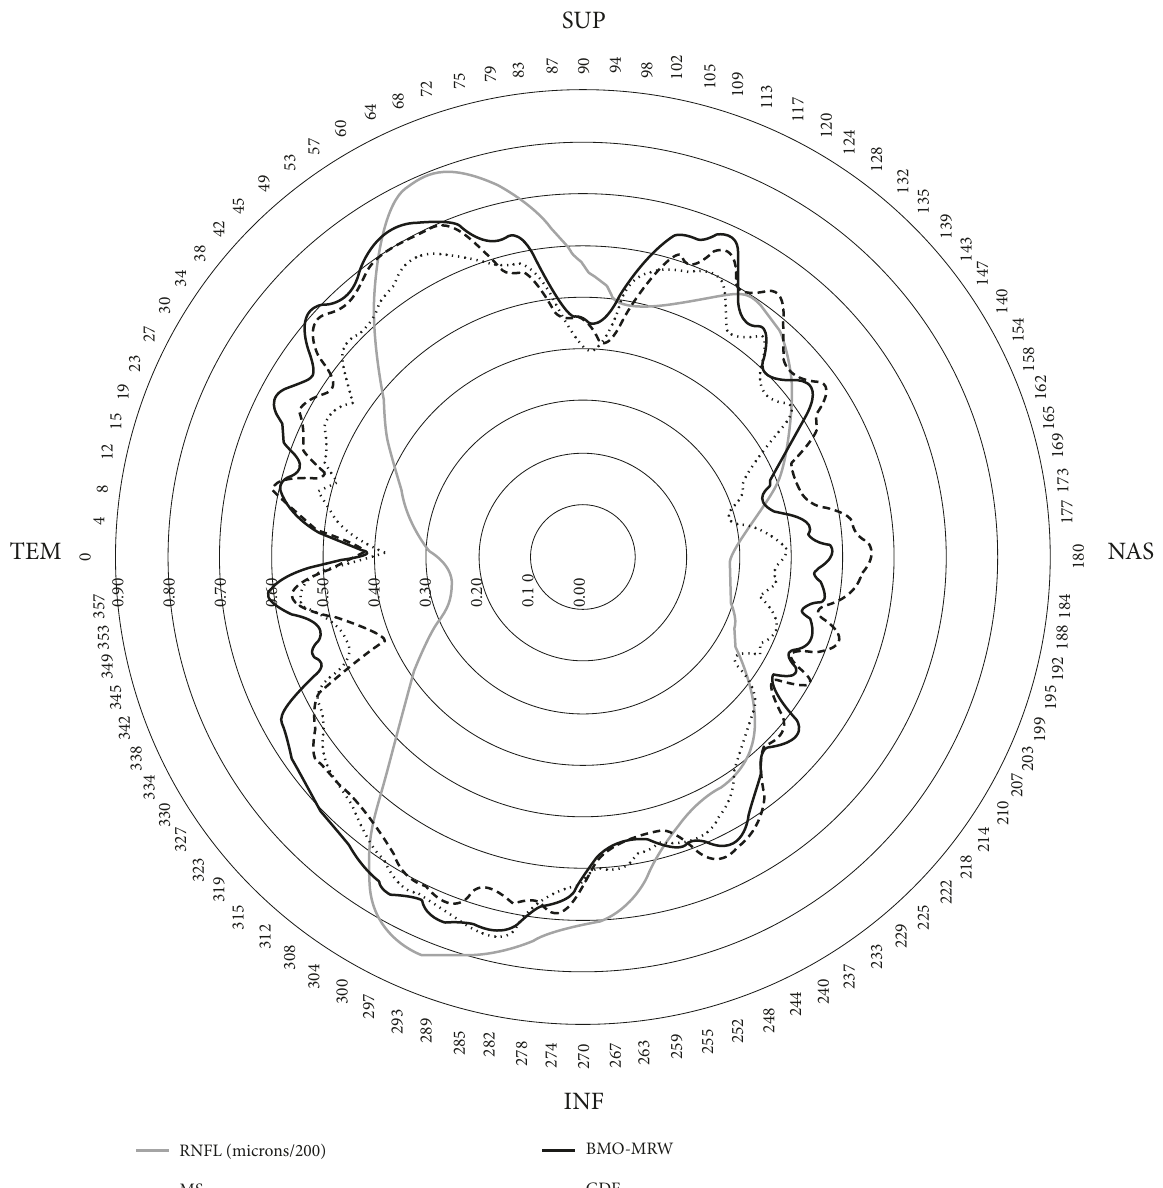
Figure 2: The black lines represent the correlation coe ffi cients (the greater the coe ffi cients, the greater the radius) of perimetric mean sensitivity (MS), SPECTRALIS OCT BMO-MRW index, and the Laguna ONhE GDF index, with respect to the 768 RNFL thicknesses measured in 360 degrees. In gray, the RNFL thickness of normal control subjects (microns/200) has been